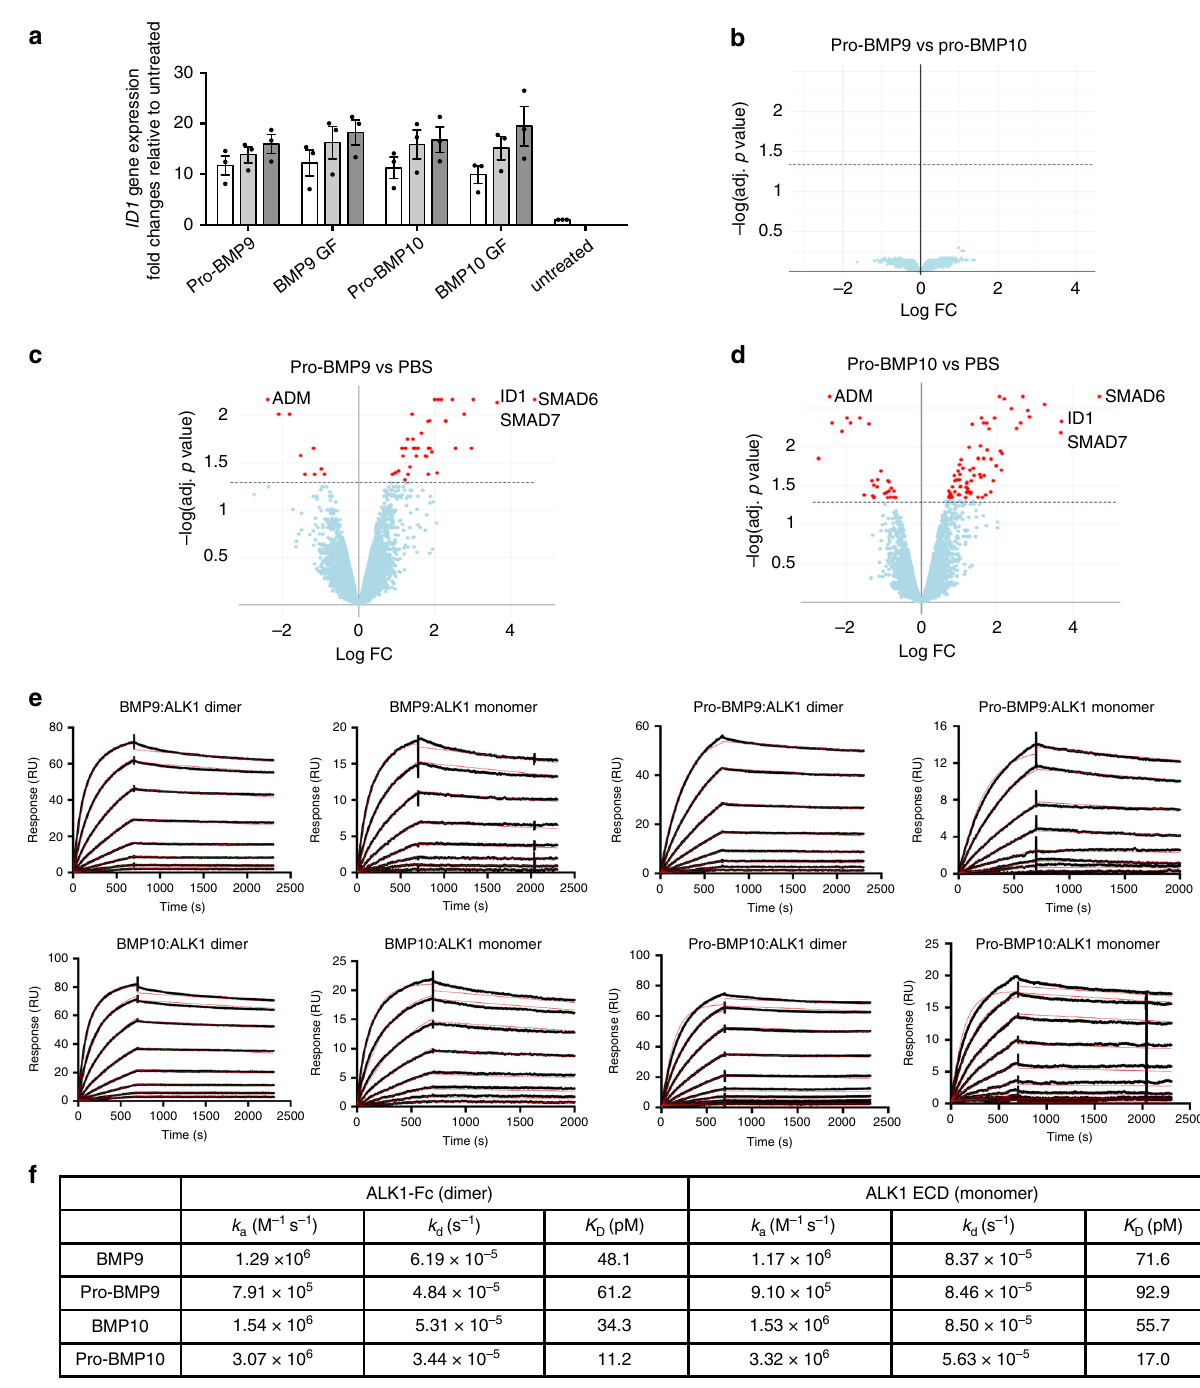
Fig. 1 Pro-BMP9 and pro-BMP10 are equivalent ALK1-ligands. a Dose-dependent signalling assays in PAECs. Serum-starved PAECs were treated with different ligands at 2.48 pM (white bars), 8.27 pM (light grey bars) and 27.3 pM (dark grey bars) (using monomer molecular weight, equivalent to 0.03, 0.1 and 0.33 ng ml − 1 BMP9 GF-domain concentration) for 1 h. Changes in the ID1 gene expression were monitored using RT-qPCR. Data were presented as fold change relative to untreated cells, and means ± SEM of three independent experiments are shown. Source data are provided as a Source Data fi le. b – d Volcano plots comparing changes in global gene expression in PAECs after pro-BMP9 or pro-BMP10 treatment. Serum-starved PAECs were treated with 25 pM of pro-BMP9 or pro-BMP10 (purity can be found on SDS-PAGE with silver staining in Supplementary Fig. 8a, lanes 1 and 4) for 1.5 h before RNA was extracted for microarray analysis. Four different primary PAEC lines were used. Red dots above the dashed line represent the changes in target genes with adjusted p values of less than 0.05. Several representative target genes are highlighted in c and d . Full list of genes can be found in Supplementary Data 1 and 2. e Af fi nity measurements of BMP9 and BMP10 for ALK1 using Biacore. A CM5 Biacore chip was immobilised with ALK1 dimer (ALK1-Fc) or monomer (in-house puri fi ed ALK1 ECD, purity can be seen in Supplementary Fig. 8a, lane 7). The sensorgrams of BMP9, pro-BMP9, BMP10 and pro- BMP10 binding raw data (in black lines) were overlaid with a global fi t to a 1:1 model with mass transport limitations (red lines). f A summary of kinetic parameters for ligand-receptor interactions derived from the Biacore measurements in e